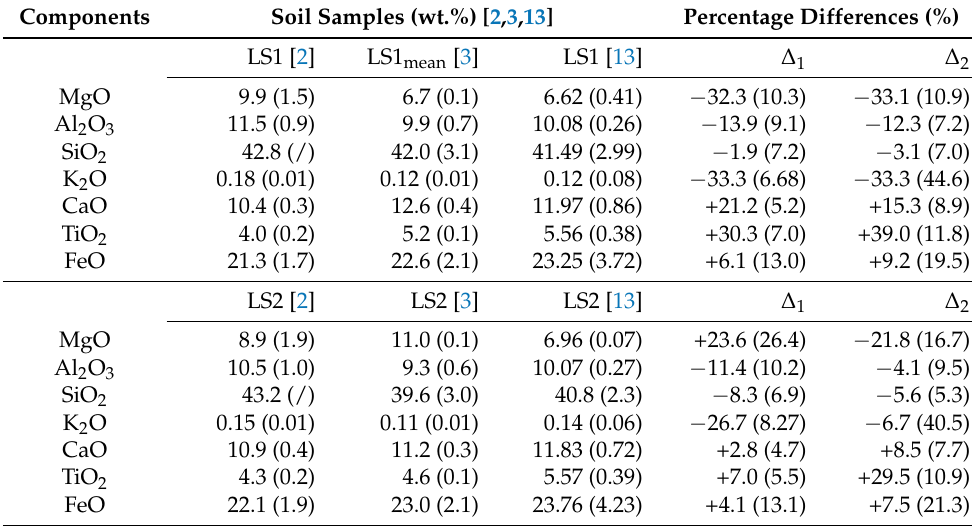
Table 1. Comparison of the results of major elements concentrations with their errors in wt.% in CE-3 landing site from previous studies